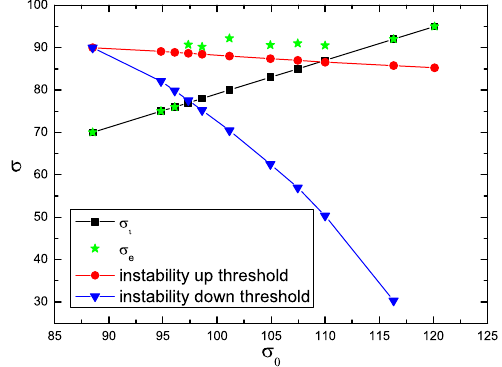
FIG. 4. Plot of initial working points σ i (black) and equilibrium state working points σ e (green) in the stability diagram for η ¼ 0 . 9